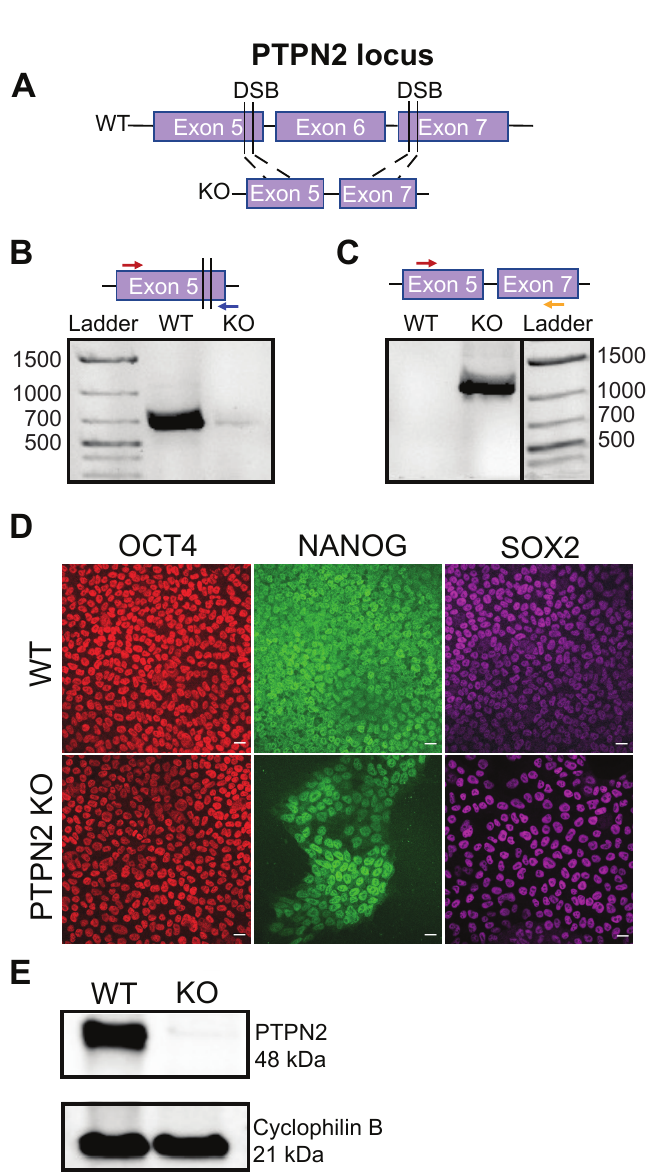
Figure 1. Generation of a CRISPR-mediated PTPN2 knockout in human pluripotent stem